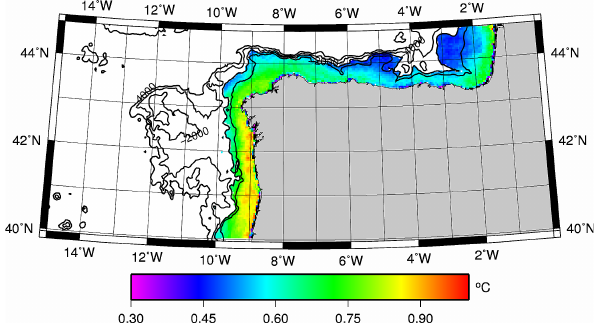
Fig. 6. First EOF of the PCA analysis of the 1981–2010 recon- structed SST dataset when only pixels with a related depth of less than 2000m are taken into account. The 200m depth contour is shown in addition to the contour depths shown in previous